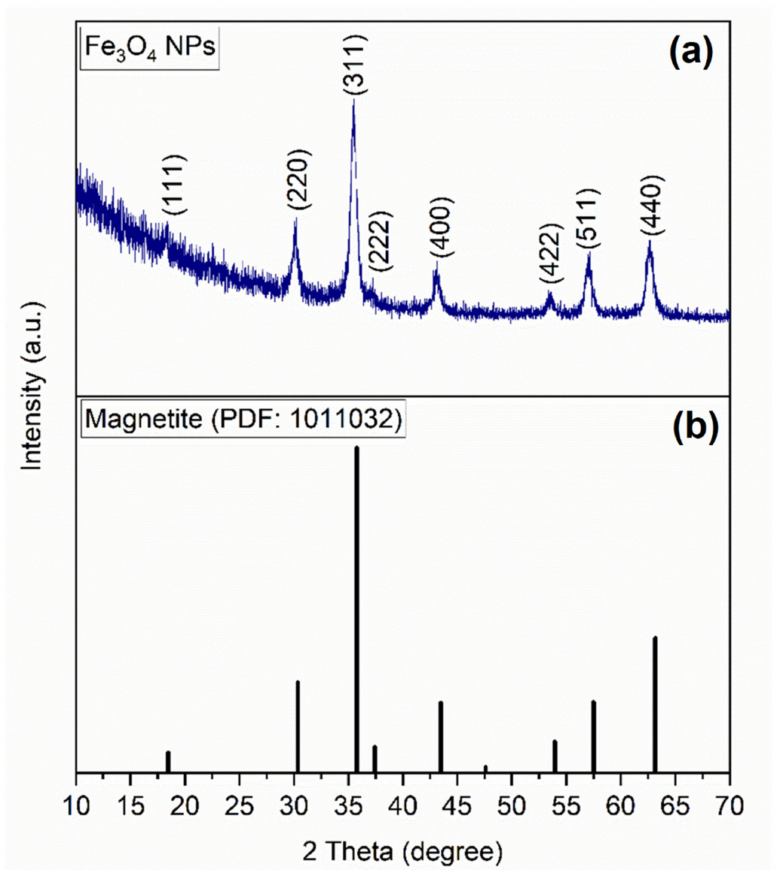
Figure 5. ( a ) XRD spectra of the Fe 3 O 4 -PAA nanoparticles; ( b ) XRD line spectra according to the standard sheet.